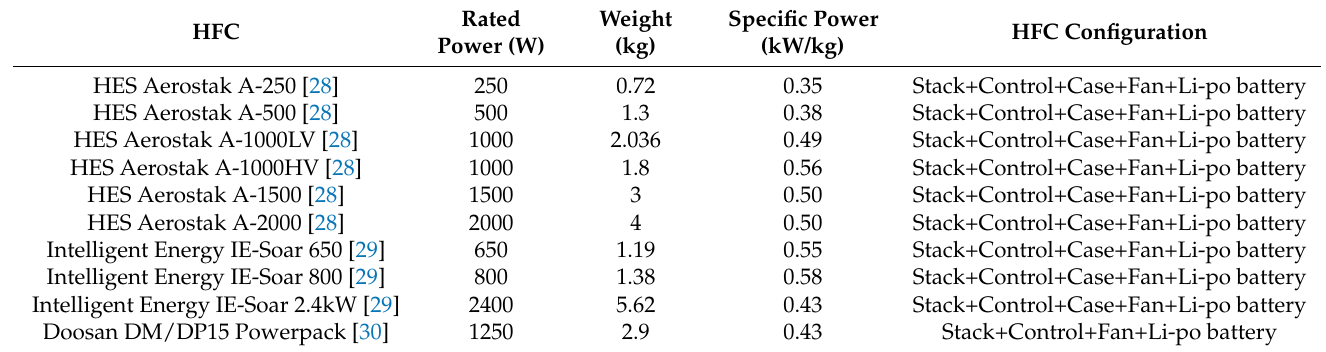
Table 5. HFC data from HES Energy Systems, Intelligent Energy, and Doosan Mobility Innovation.